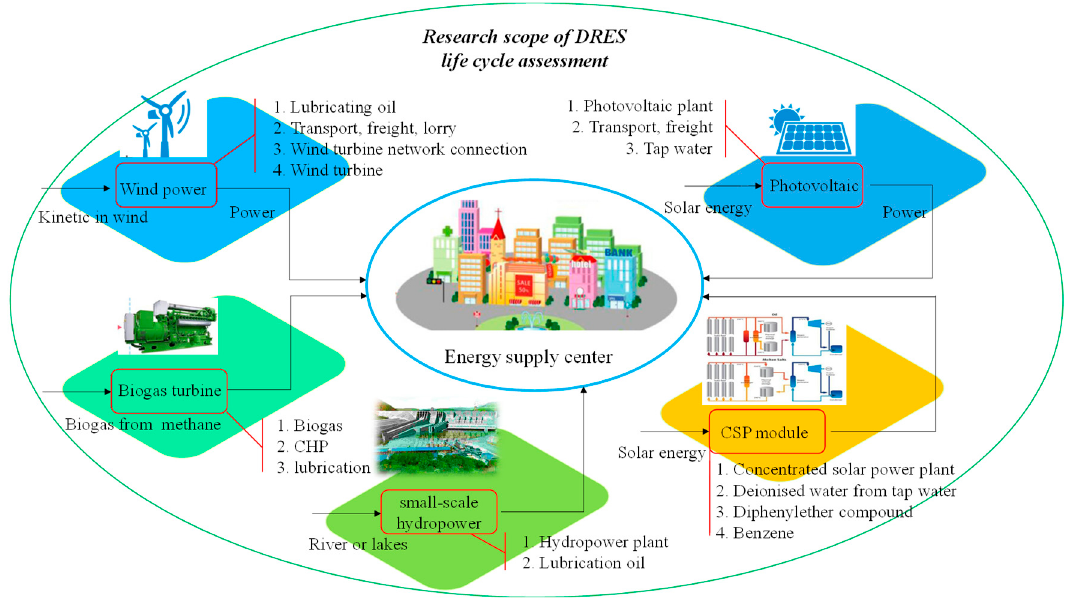
Figure 3. Research profile of demonstrated distributed renewable energy system for life cycle assessment.